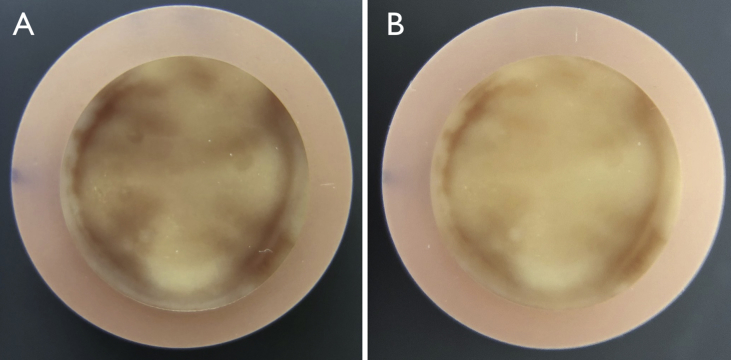
Representative photographic images of a human dentin specimen stained with human whole blood for 3 weeks (A) and then bleached from the treatment side (see Fig. 1) for 60 min using a combined aqueous irrigant containing 2.5% NaOCl and 9% HEDP. The ΔE* value in this specific specimen was 4.7, the ΔL was 3.2.